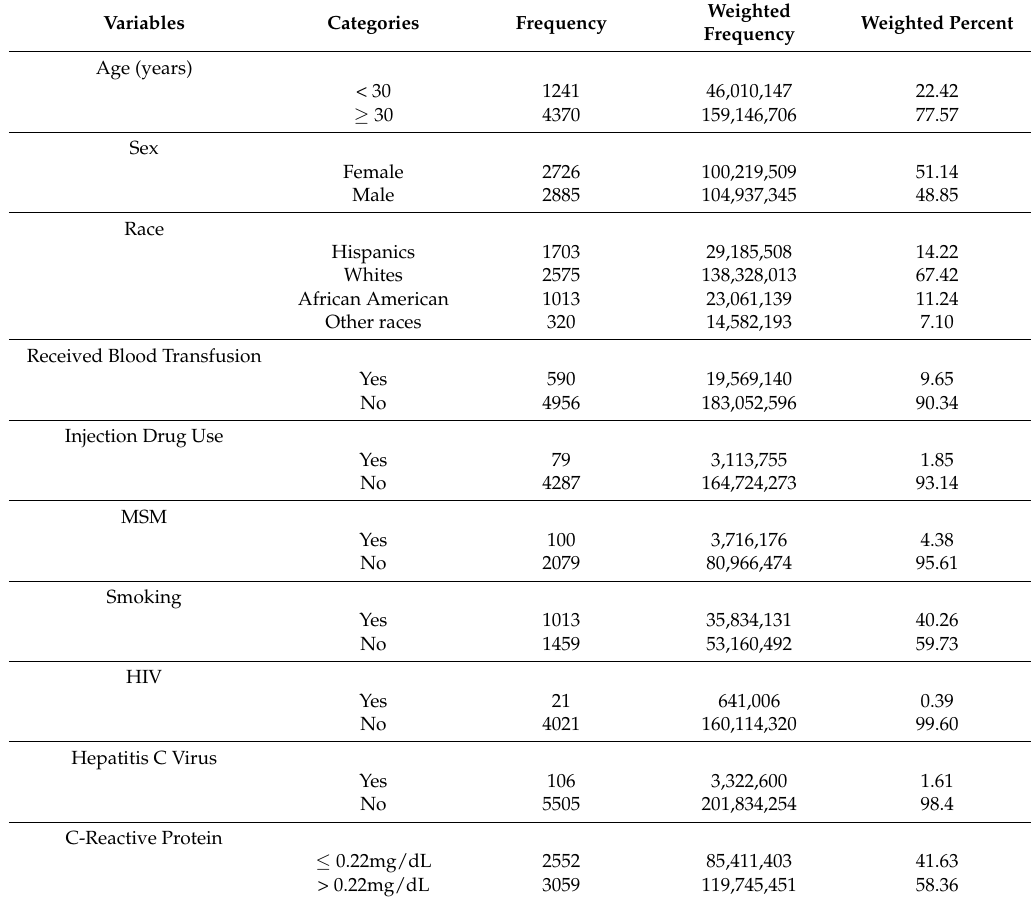
Table 1. Demographic characteristics of